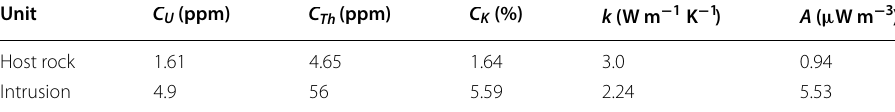
Table 7 Parameters used for the heterogeneous basement model Unit